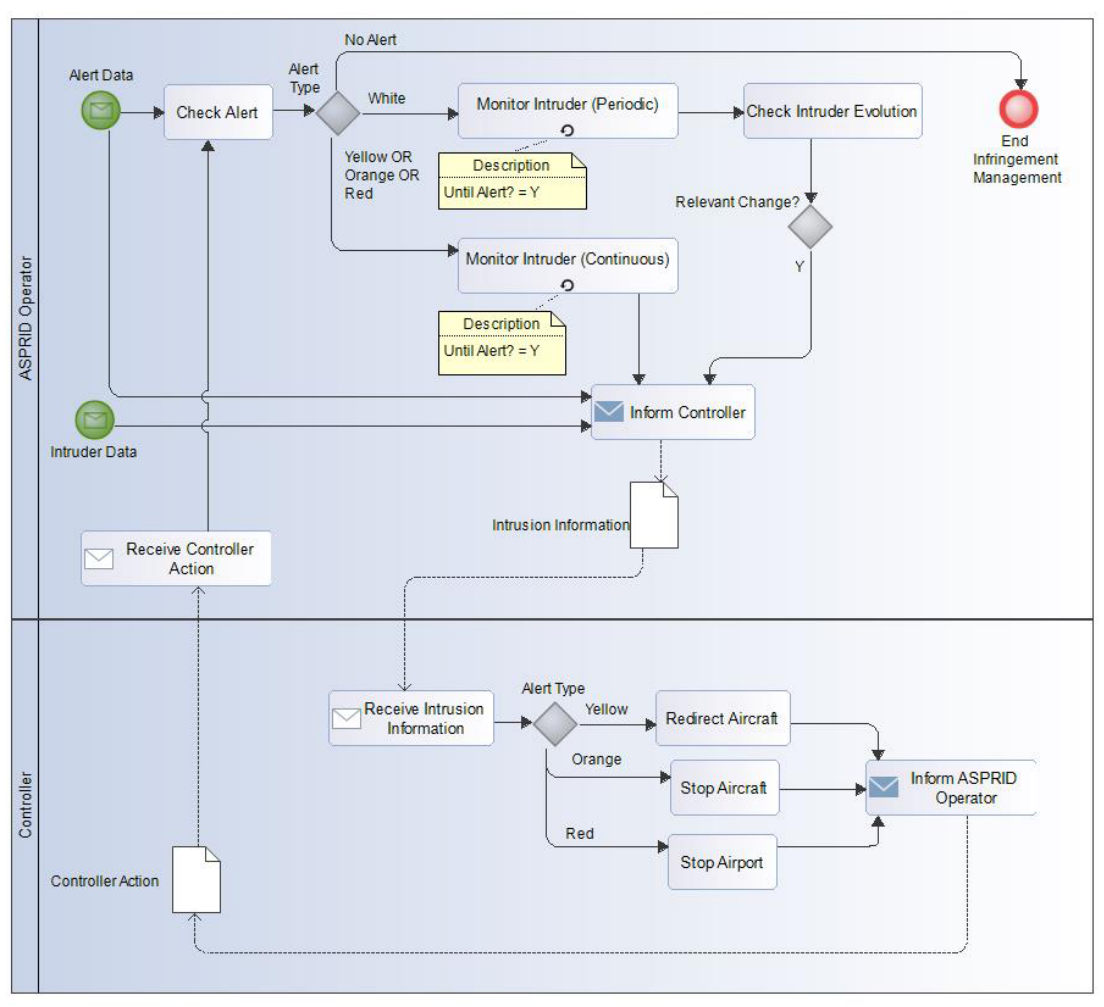
Figure 5. BPMN process diagram of ASPRID operational procedure: subprocess for infringement management.